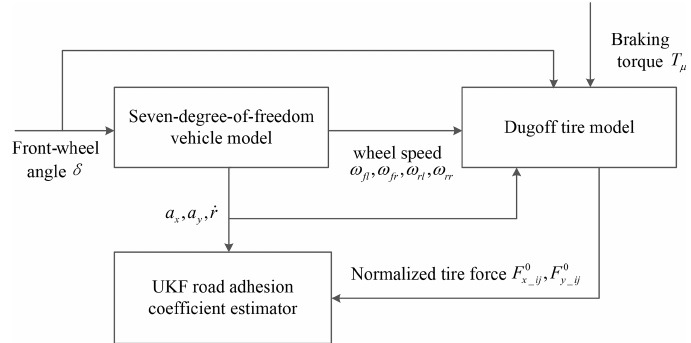
Figure 2. Schematic diagram of the road adhesion coefficient estimation based on the UKF.